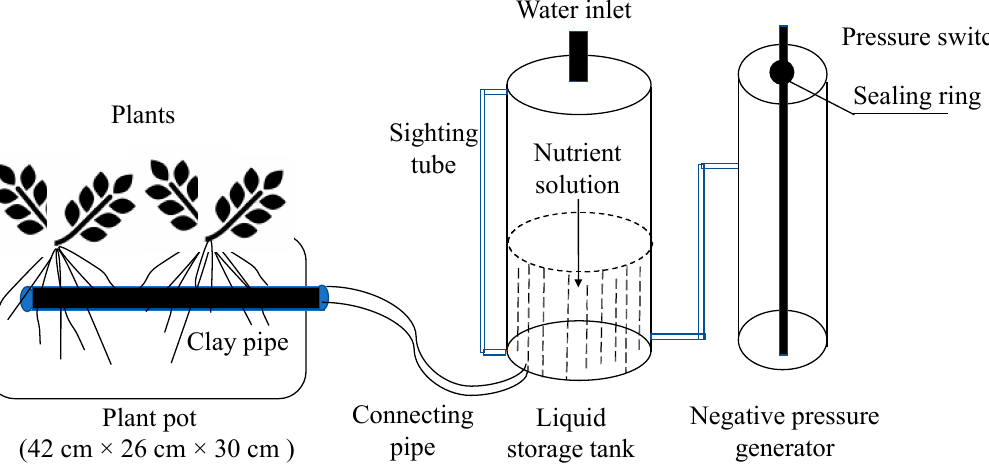
Figure 1. Schematic of lettuce growth using a negative pressure irrigation system.